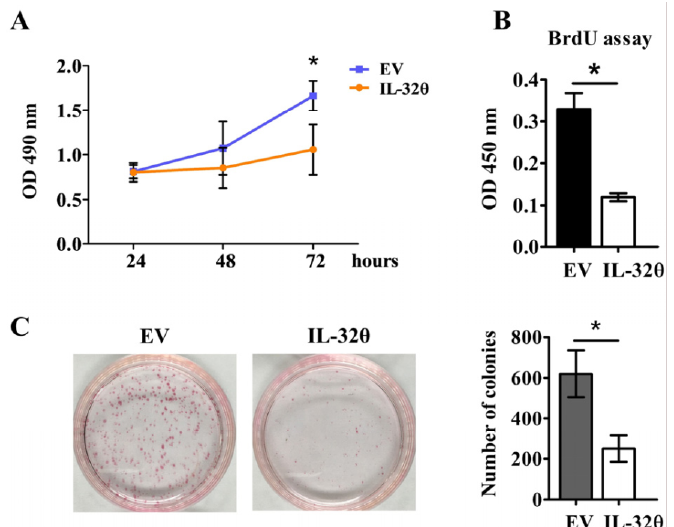
Figure 1. Antiproliferative effects of IL-32 θ on MDA-MB-231 breast cancer cells. ( A ) Cells were seeded and incubated overnight for attachment, then cell viability was assessed using MTS assays at indicated time points. ( B ) Incorporation of BrdU after 72 h, indicating proliferative cells. ( C ) Colony forming ability was analyzed 10 days after seeding 1 × 10 3 cells in 6-well plates. * p < 0.05 (Student t -tests). Results are representative of three independent